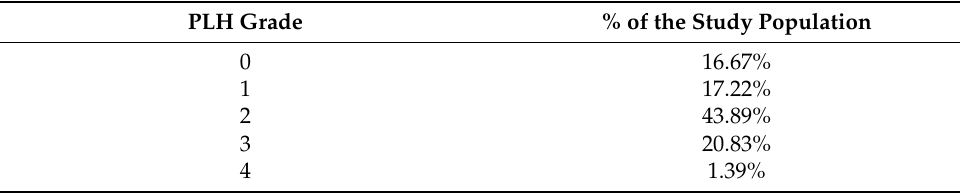
Table 1. Frequency and distribution of pharyngeal lymphoid hyperplasia (PLH) grades among the study population.